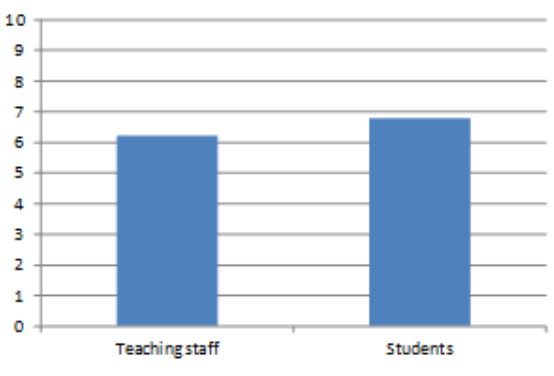
Figure 4. Marks of the tests of short